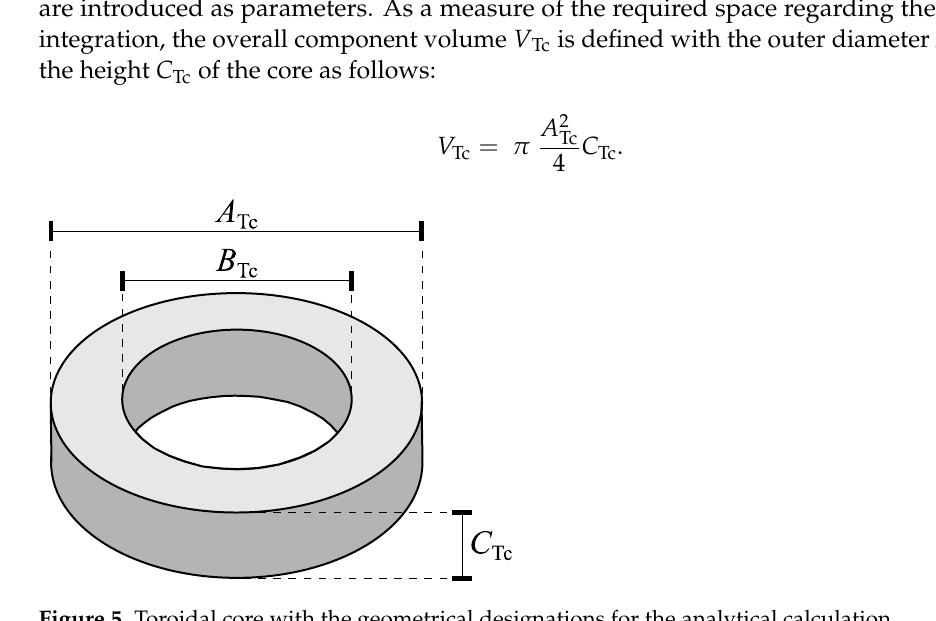
Figure 5. Toroidal core with the geometrical designations for the analytical calculation. The flowchart describing the optimization strategy for the PFC inductance is shown in Figure 6. Utilizing the data of the operating point of the PFC from Section 3.1, the progression of the coil current i L ( t ) is calculated by setting L PFC and f sw,PFC . With the material data and a specified volume V Tc , the core and winding losses in the component are calculated for all combinations of Θ B and Θ C . As a result of this optimization, the optimal coil design is obtained depending on its volume and the selected operating point, which further leads to the representation of a Pareto frontier based on the respective parameter.